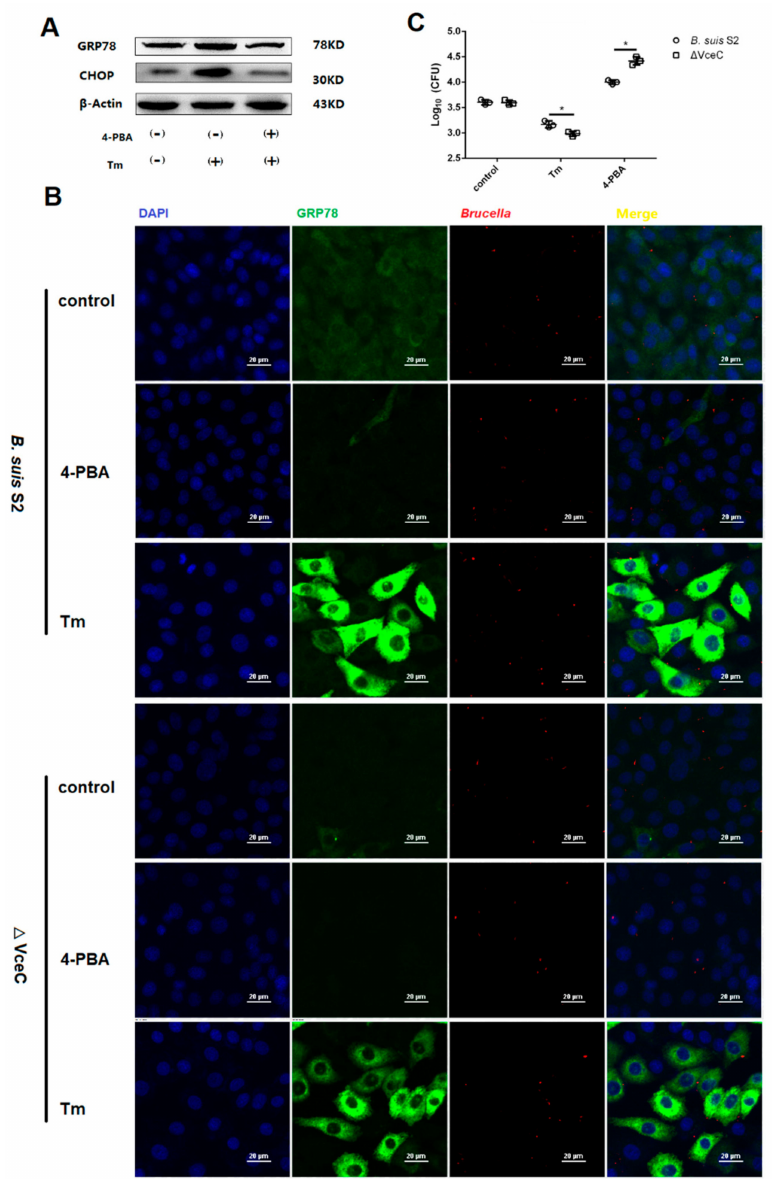
Figure 5. Intracellular survival of B. suis S2 and ∆ VceC by changing endoplasmic reticulum (ER) stress. ( A ) The UPR marker GRP78 and CHOP were analyzed using Western blot by treating with 0.5 µ g / mL Tm or 1 µ M 4-PBA in GTCs to establish an ER stress activated and inhibited model. The data shown are representative of three independent experiments. ( B ) (bar = 20 µ m) Representative confocal micrographs of GRP78 protein (green) infected with B. suis S2 (red) and ∆ VceC (red) by added 0.5 µ g / mL Tm or 1 µ M 4-PBA before infection in GTCs. The blue represents cell nucleus. ( D – E ) CFUs of B. suis S2 ( C ) and ∆ VceC ( D ) were determined in GTCs at 24 h post infection. The 0.5 µ g / mL Tm or 1 µ M 4-PBA was added before infection. Data represent the mean ± standard deviation from three independent experiments. * p <